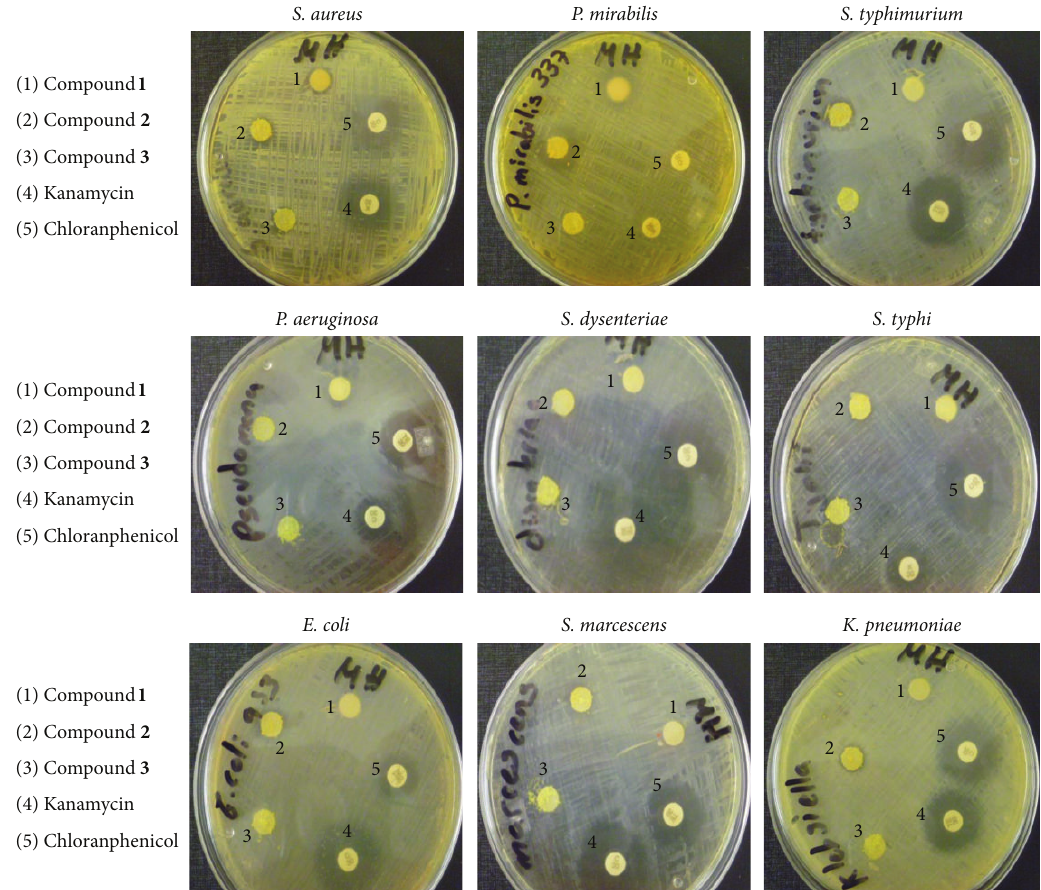
Figure 5: Photographs of the antimicrobial activities of compounds 1 , 2 , and 3 against S. aureus , P. mirabilis , S. typhimurium , P. aeruginosa , S. dysenteriae , and S. typhi , showing their inhibition zone.